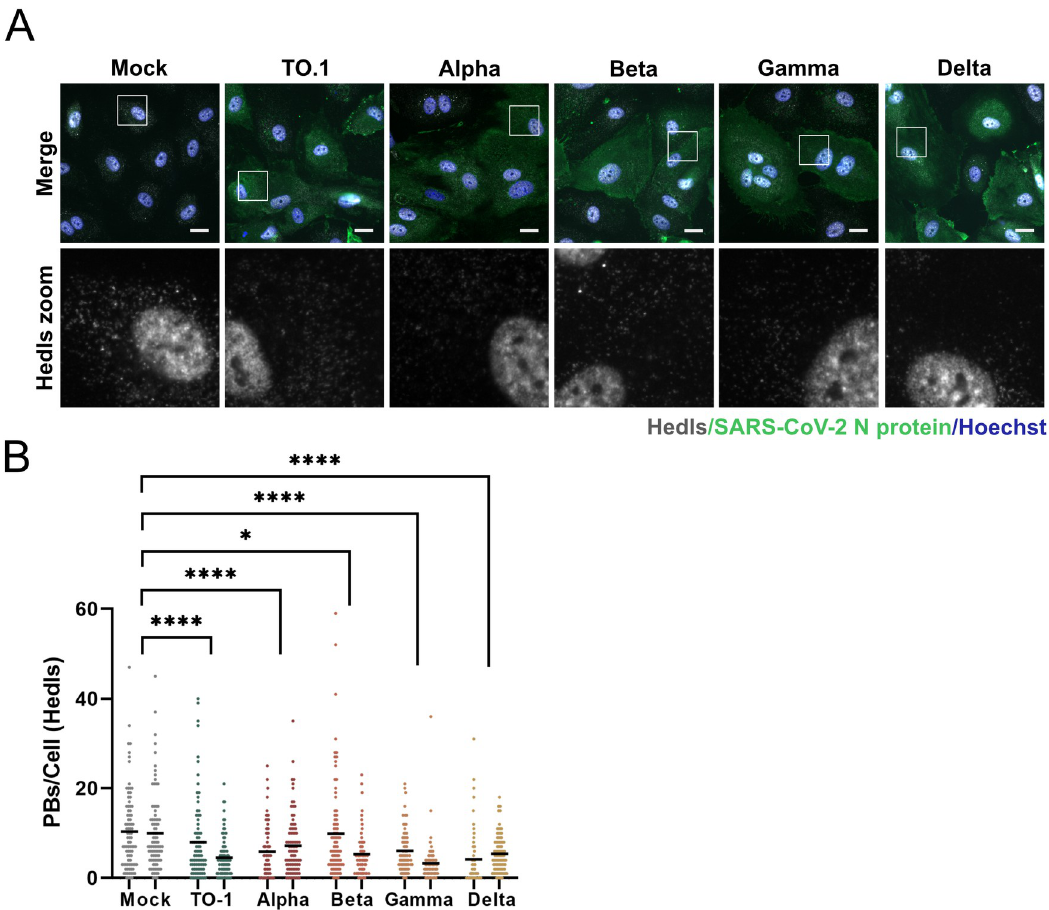
Fig 2. Processing bodies are absent in SARS-CoV-2 Alpha, Beta, Gamma, and Delta variant infected cells. A. HUVECs were transduced with recombinant lentiviruses expressing human ACE2 (HUVEC ACE2 ), selected and infected with SARS-CoV-2 TO-1, Alpha, Beta, Gamma, or Delta isolates (MOI = 2), or a mock infection control. 24 hours post infection cells were fixed and immunostained for SARS-CoV-2 N protein (green; Alexa488) and Hedls (white; Alexa555). Nuclei were stained with Hoechst (blue). Representative images from one of two independent experiments are shown. B. PBs were quantified as in Fig 1. These data represent two independent biological replicates ( n = 2 ) with > 80 cells measured per condition (mock and infected) per replicate. Each mock and infected replicate pair plotted independently; mean. Statistics were performed using Kruskal-Wallis H test with Dunn’s correction ( � , p < 0.0332; ���� , p < 0.0001). Scale bar = 20 μ M.